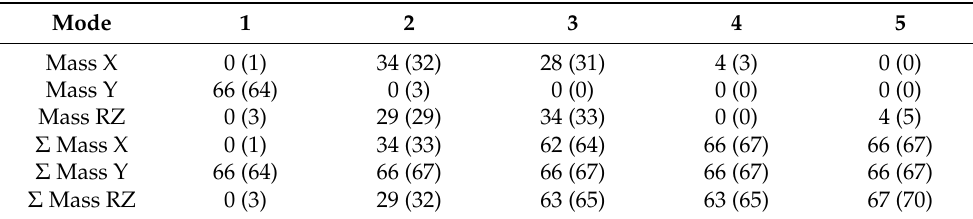
Table 2. Modal participating masses of models FEM2010 and FEM2016 (in parentheses). Mode